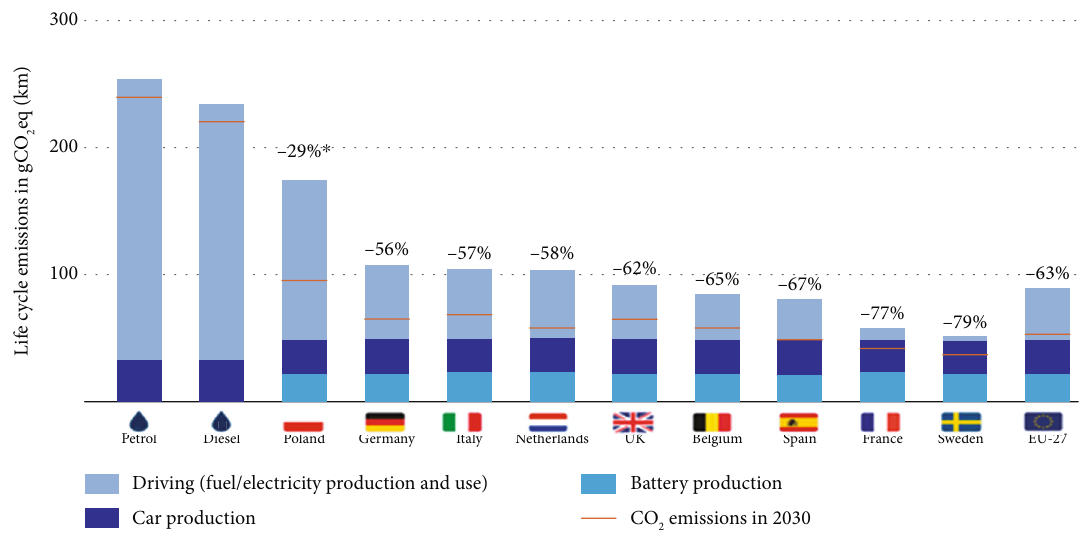
) e ffl uent savings from electric vehicles (worst-case) [33]. 2